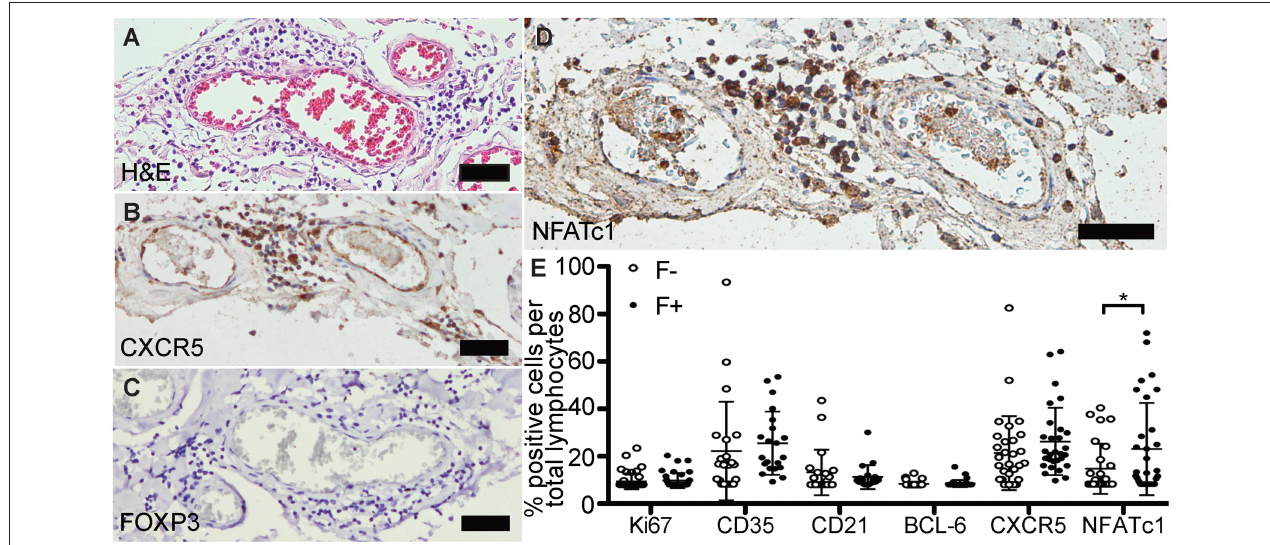
FIGURE 3 | Follicle-like structures of SPMS brains are devoid of FOXP3 expression, but exhibit NFATc1 + cells. (A) Representative meningeal follicle-like structure of SPMS spinal cord, which was screened based on H&E staining and characterized by > 60 lymphocytes (score 3), detection of Ki67 + , CD35 + /CD21 + , and CD138 + cells on serial sections, termed F + . F–, if no or not all criteria were fulfilled. (B) Follicle-like structures could be characterized by CXCR5 + , (C) but not by FOXP3 + cells. (D) NFATc1 + cells were present in follicle-like structures. (E) IHC stainings of Ki67, CD35, CD21, BCL-6, CXCR5, and NFATc1 were quantified as frequency of total cells in follicle-like structures (F + ) and less defined infiltrates (F-). Ki67 : F-, M = 1.52, SD = 3.73, n = 45; F + , M = 1.89, SD = 3.55, n = 38; Mann Whitney test, U = 734.0, p = 0.161. CD35 : F-, M = 15.41, SD = 22.95, n = 22; F + , M = 19.05, SD = 14.75, n = 21; Mann Whitney test, U = 159.0, p = 0.081. CD21 : F-, M = 5.68, SD = 10.63, n = 21; F + , M = 3.51, SD = 5.60, n = 20; Mann Whitney test, U = 183.5, p = 0.488. BCL-6 : F-, M = 0.32, SD = 1.08, n = 44; F + , M = 0.49, SD = 1.62, n = 38; Mann Whitney test, U = 803.0, p = 0.642. CXCR5 : F-, M = 14.72, SD = 17.24, n = 30; F + , M = 20.11, SD = 15.73, n = 29; Mann Whitney test, U